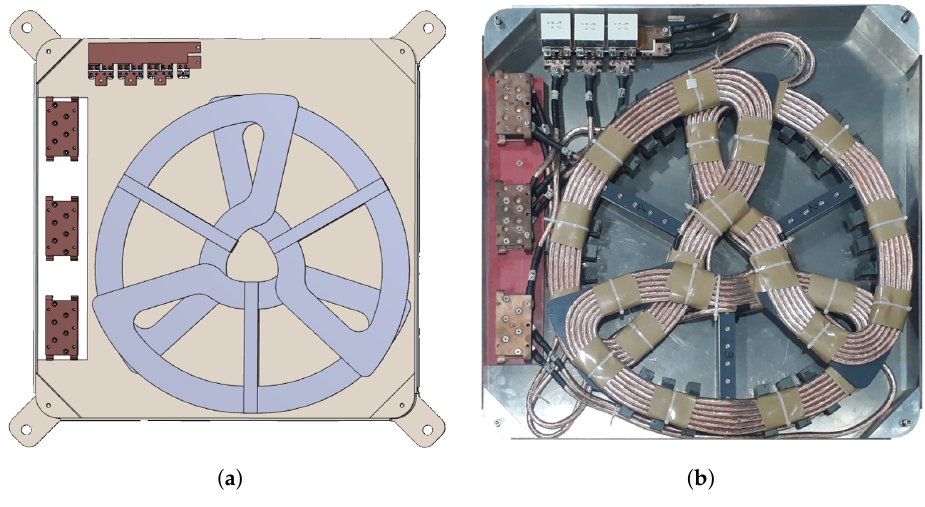
Figure 8. ( a ) WPT 3D-CAD model. ( b ) WPT manufactured RX-unit.